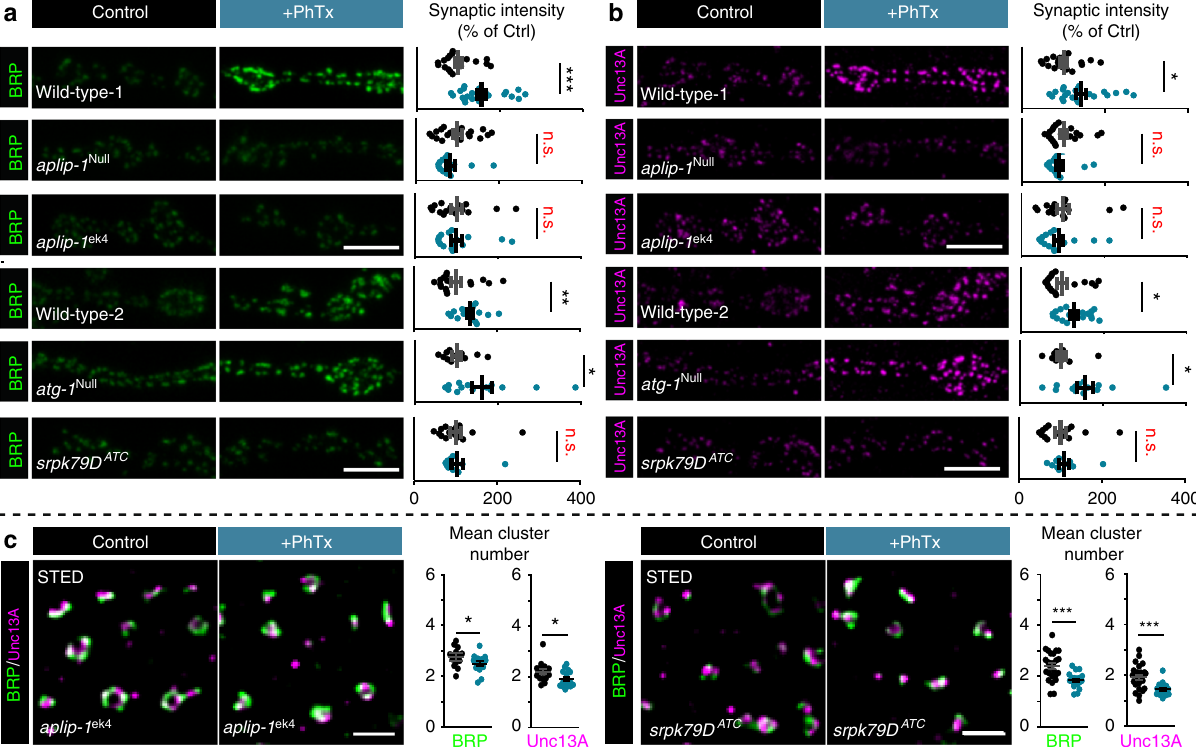
Fig. 3 Rapid AZ-remodeling during PHP requires Aplip-1 and Srpk79D. a , b Muscle 4 NMJs of segment A2-A5 from third instar larvae and quanti fi cation of synaptic levels of wild-type — 1, aplip-1 Null , aplip-1 ek4 , wild-type-2, atg1 and srpk79D ATC labelled with the indicated antibodies without (Ctrl; black) and with 10 min of PhTx ( + PhTx; blue) treatment. Two independent experiments were performed, wild-type-1 was used as control for aplip-1 Null and aplip-1 ek4 while wild-type-2 was used for atg1 Null and srpk79D ATC . c Average BRP and Unc13A cluster number per AZ either without (Ctrl, − PhTx; black) or with PhTx ( + PhTx; blue) treatment in aplip-1 ek4 and srpk79D ATC . See also Supplementary Figs. 5, 6 and Movie 1. Source data as exact normalized and raw values, detailed statistics including sample sizes and P values are provided in the Source Data fi le. Scale bars: a , b 5 µ m; c 500 nm. Statistics: Mann – Whitney